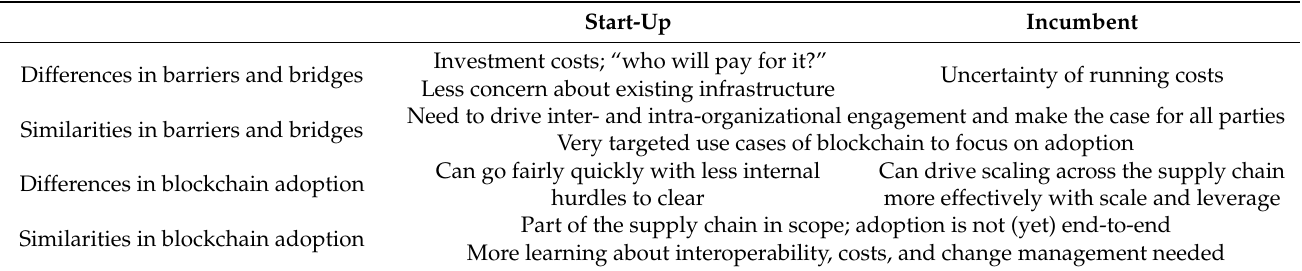
Table 3. Overview of differences in blockchain barriers and adoption between start-ups and incumbents. Start-Up Incumbent Investment costs; “who will pay for it?” Uncertainty of running costs Differences in barriers and bridges Less concern about existing infrastructure Similarities in barriers and